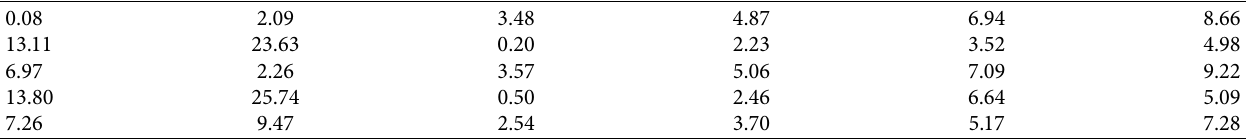
Table 1: Progressive type-II failure data.